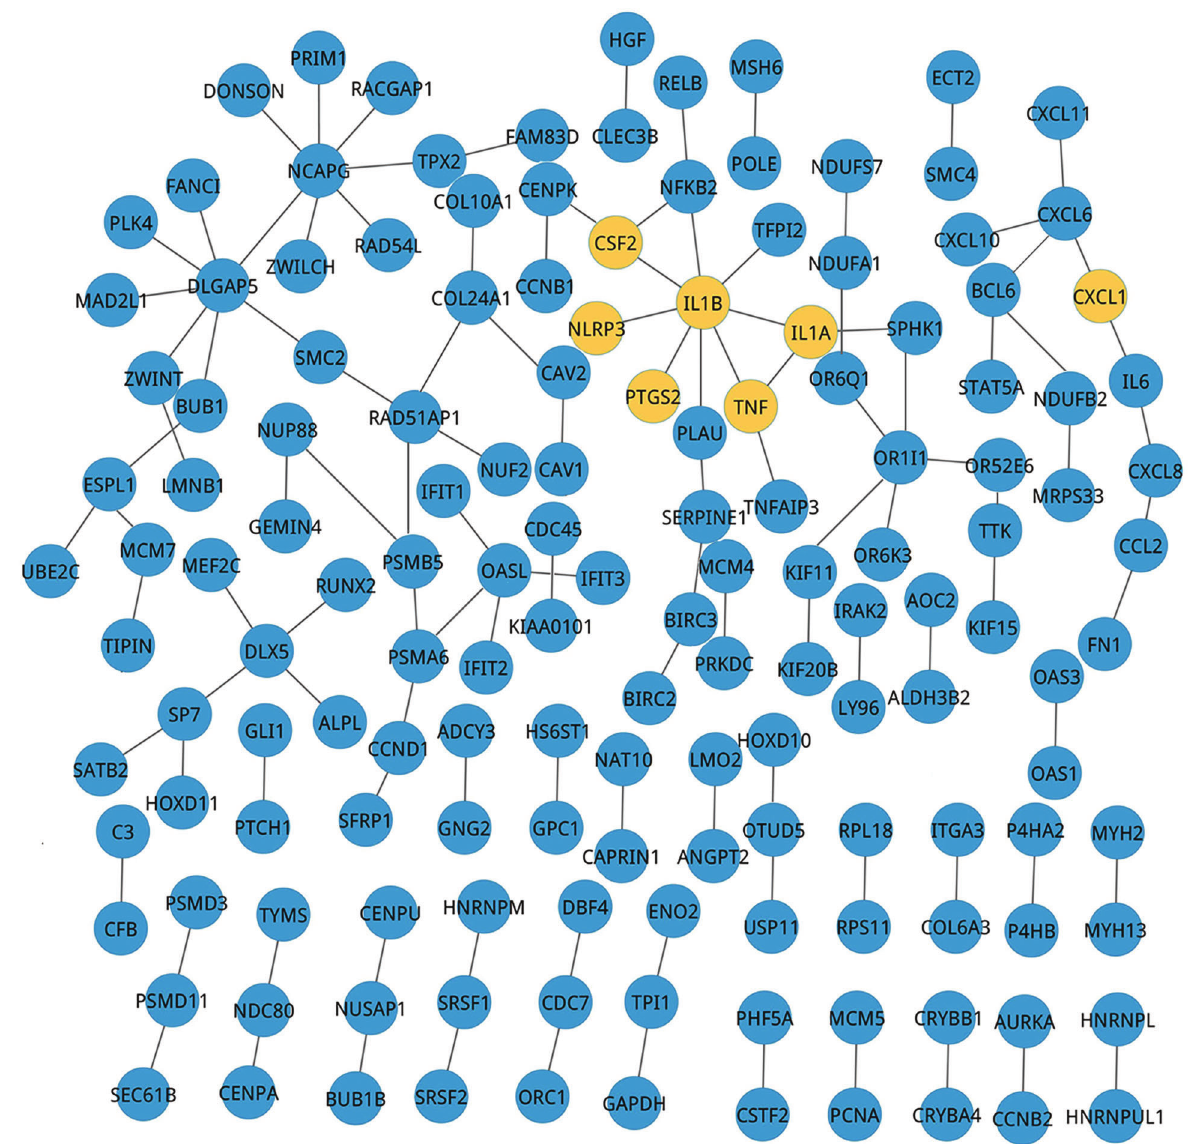
Figure 2. Differential expression network (DEN) for osteosarcoma. Nodes represent genes, and edges are interactions between any two genes. The yellow ones were selected as ego